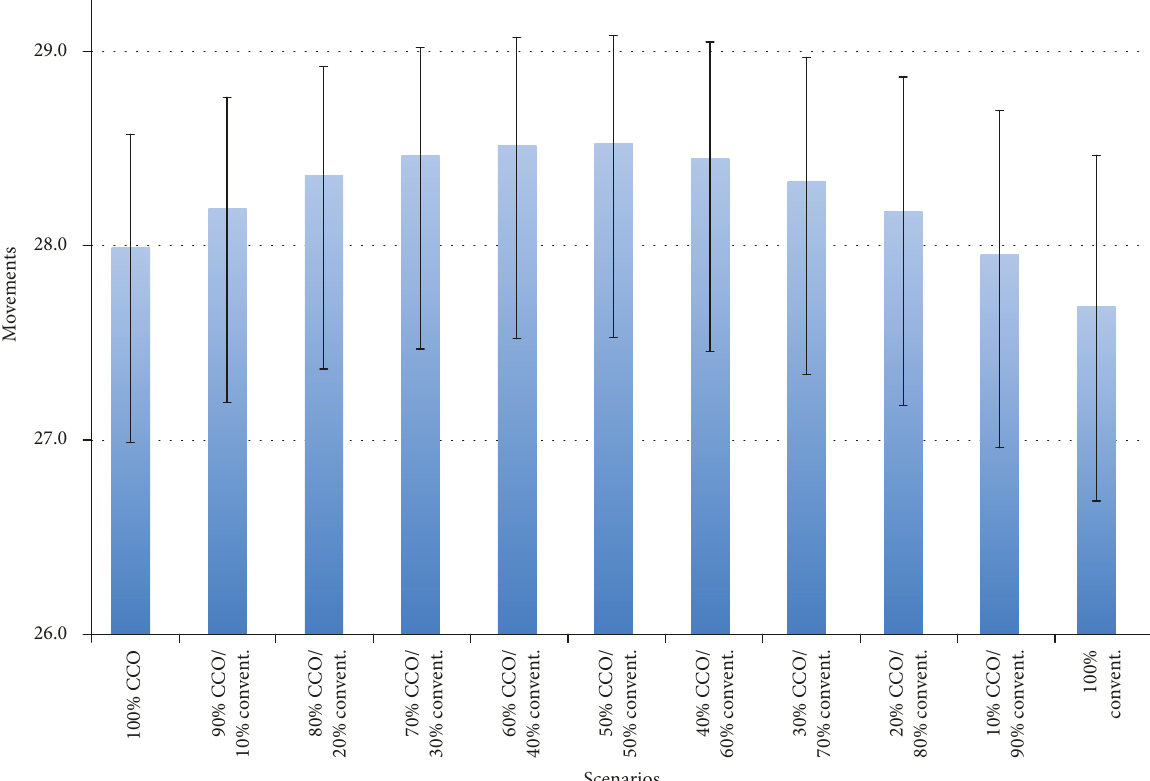
Figure 5: Capacity. Mean capacity values are represented by the bar plot and the associated standard deviations of the sample are illustrated by the